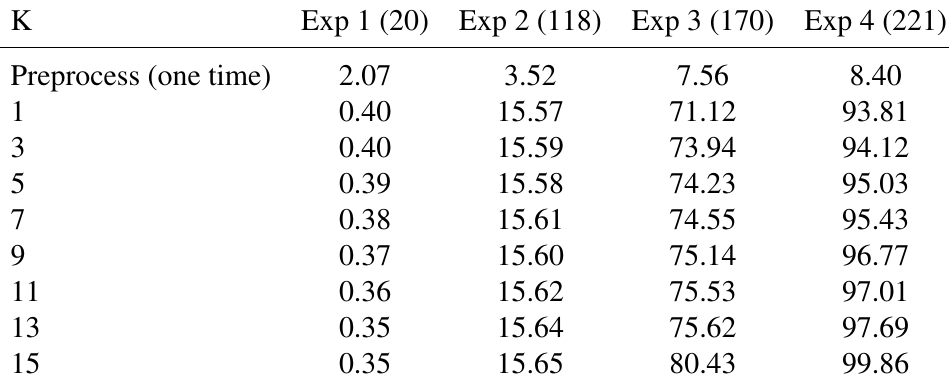
Table 6: Execution times (in minutes) of each experiment and K